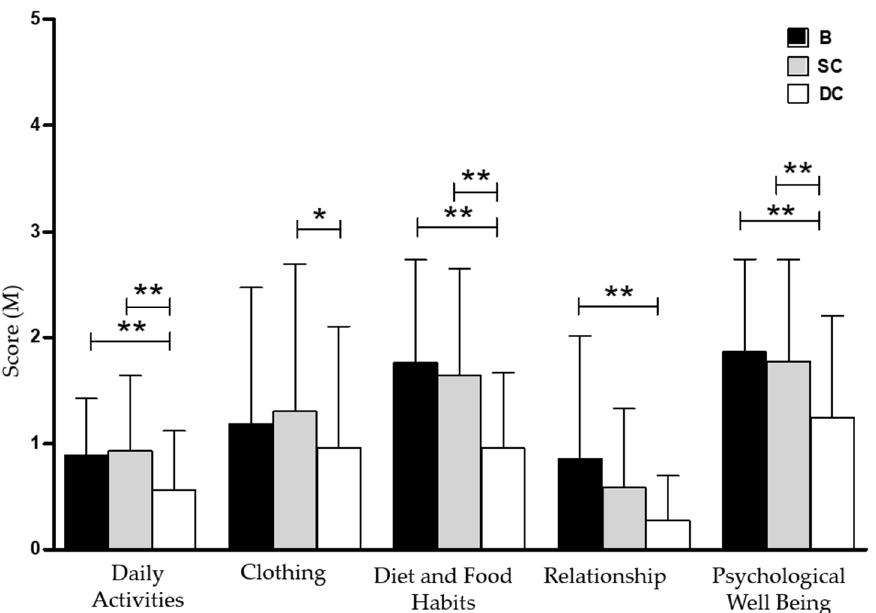
Figure 4. PAGI-QoL subscales score at basal condition and after both treatment periods. Data are presented as mean ± SD ( n = 40). B, Basal Conditions; DC, Dewaxed Coffee; SC, Standard Coffee. * p < 0.05; ** p < 0.01.